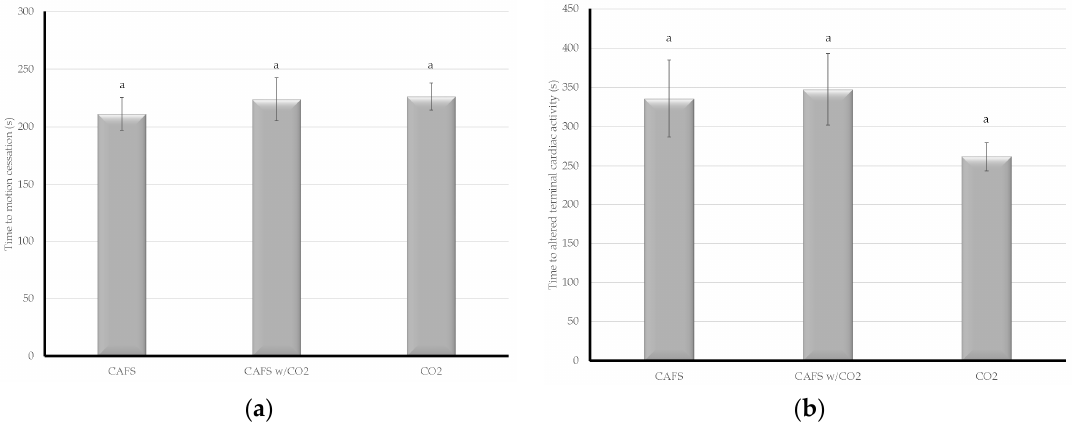
Figure 2. The time from treatment to physiological parameters during depopulation of caged layer hens under one of three treatments was evaluated. Letters within a given chart denote assigned connected letters report with differing letters representing statistical significance. ( a ) There was no statistically significant difference in time to cessation of motion (COM) between treatments; ( b ) there was no statistically significant difference in time to altered terminal cardiac activity between treatments.